Question: Identify the chart type used in this figure.
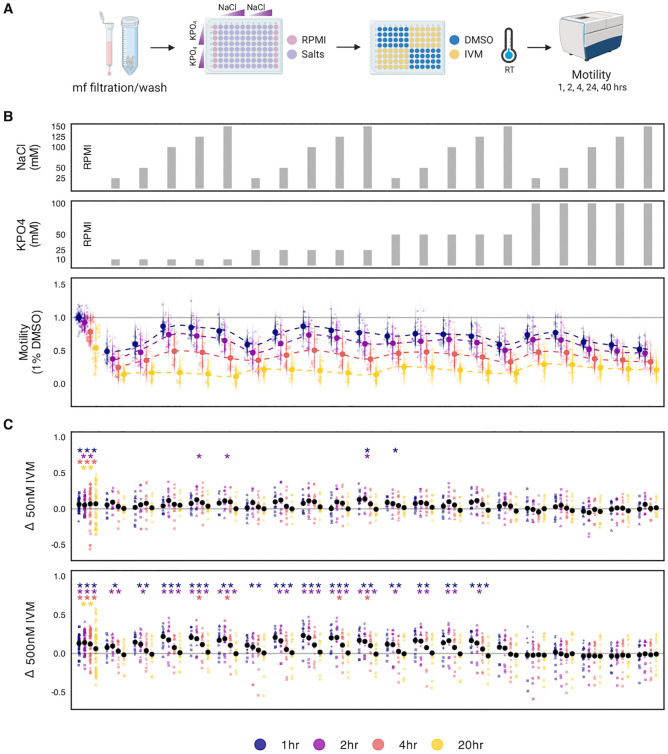
Answer: bar